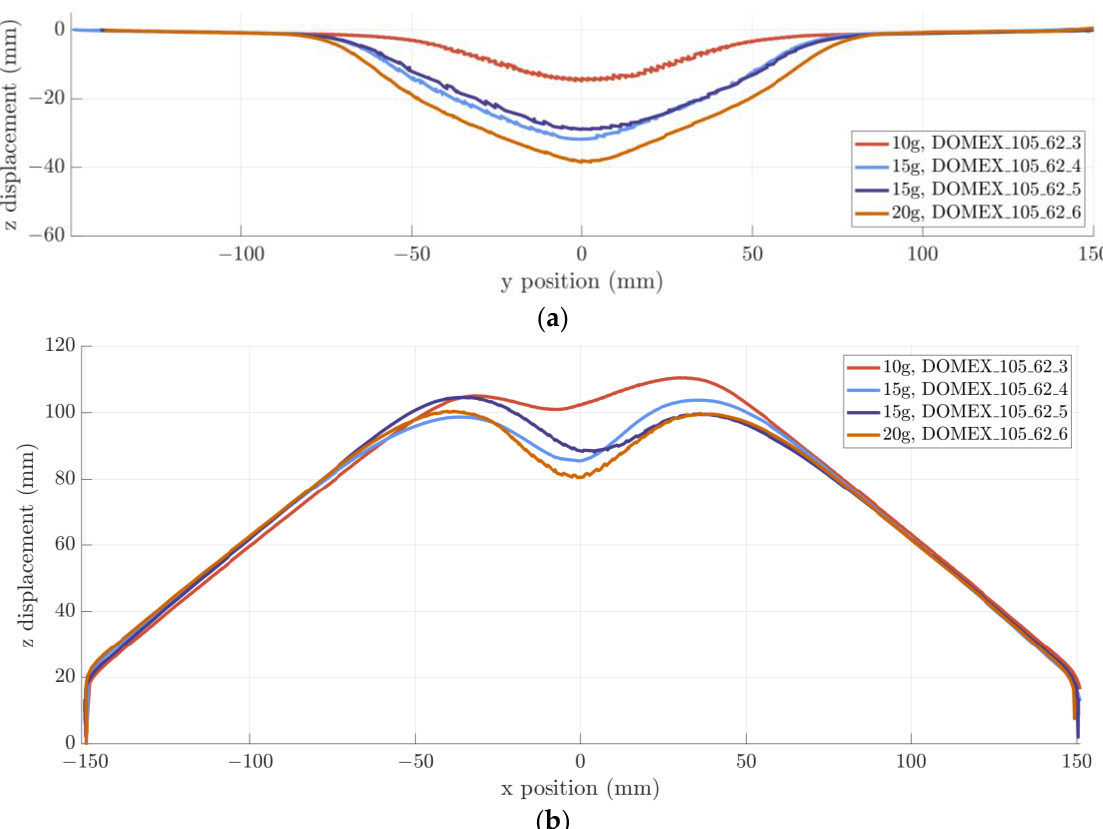
Figure 9. Permanently deformed profiles of blast tested V-structures (105° internal angle, 62 mm tip radius) of the ( a ) ridge plane, ( b ) cross-cut plane.